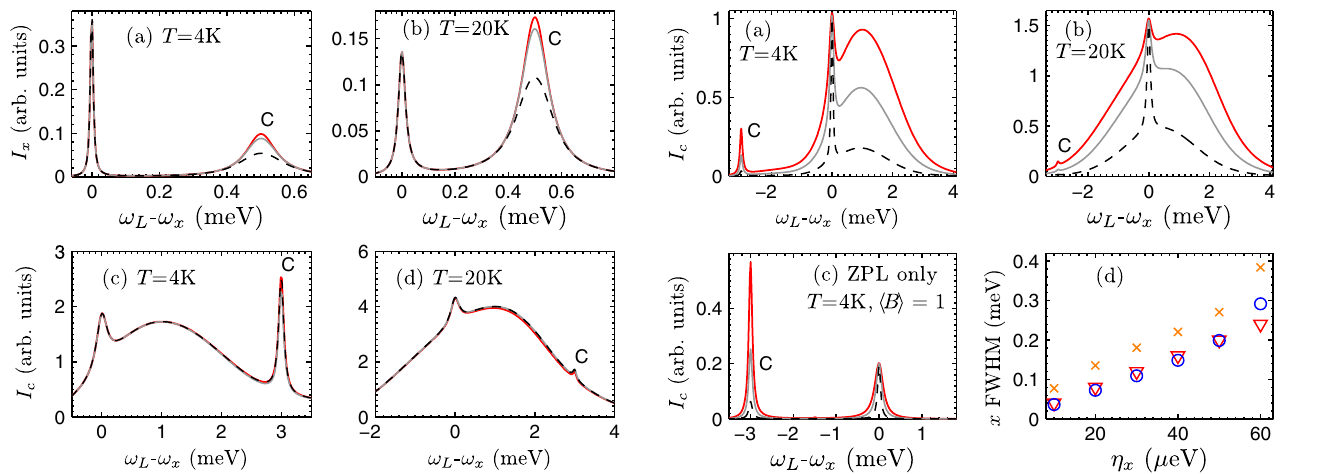
FIG. 9. (a)-(b) Exciton PL intensity for a cavity-driven system ¼ 30 (cid:8) eV ) as a function of QD-laser detuning (with (cid:1) ( (cid:4) c 0 : 5 meV ), for different numbers of truncated photon states at (a) T ¼ 4 K and (b) T ¼ 20 K : two-photon (or more, since this value has converged): black dashed line, four-photon: grey solid line, six-photon (or more): red solid line. (c)-(d) Mean cavity- photon number for a dot-driven system as a function of QD-laser ¼ 3 meV ), for a different number of trun- detuning (with (cid:1) cx cated photon states with (c) T ¼ 4 K and (d) T ¼ 20 K : one-photon: black dashed line, two-photon: grey solid line, and three-photon: red darker line.